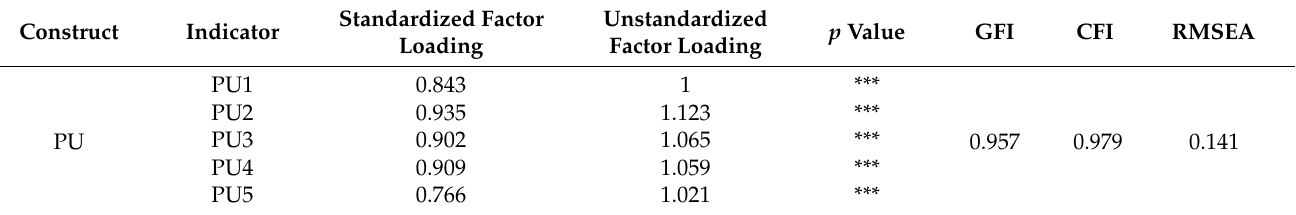
Table 2. CFA of perceived ease of use.